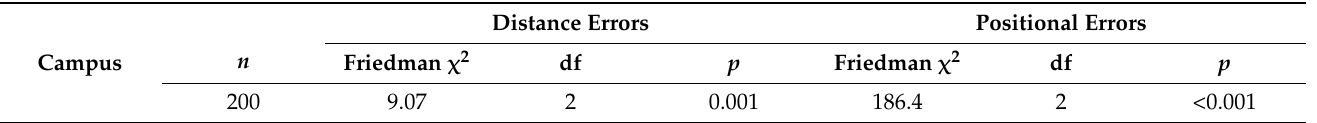
Table 5. For distance errors and positional errors of the campus area, total sample size, n , Friedman chi-square, χ 2 , the degrees of freedom for Friedman chi-square, df; the p -value, p , were reported.